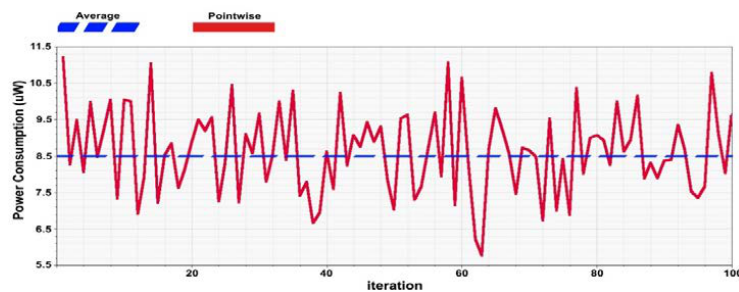
Figure 13. Monte Carlo simulation of the recovered clock with 500 iterations.